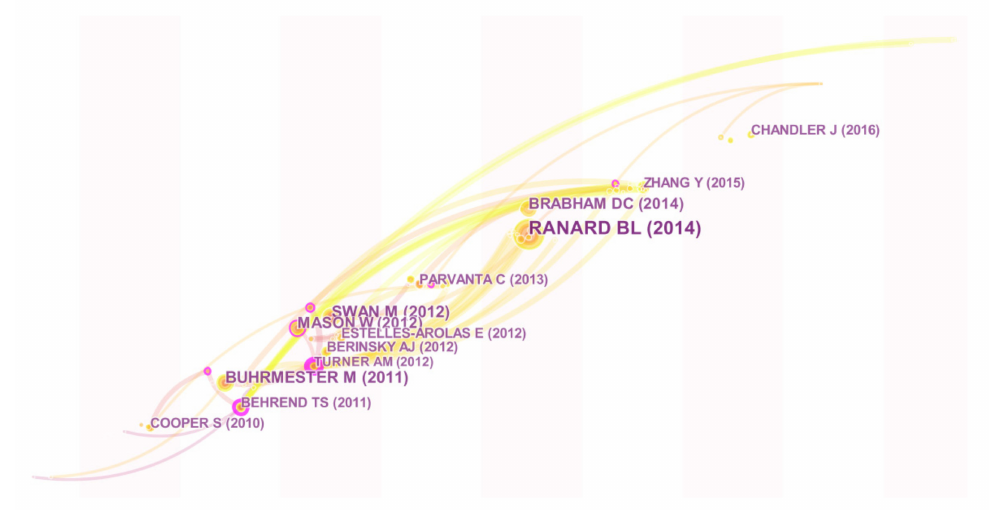
Figure 6. Visualization of reference time zone analysis.